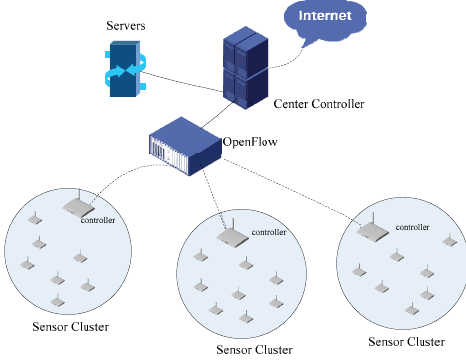
Figure 2. Software defined wireless sensor network architecture.